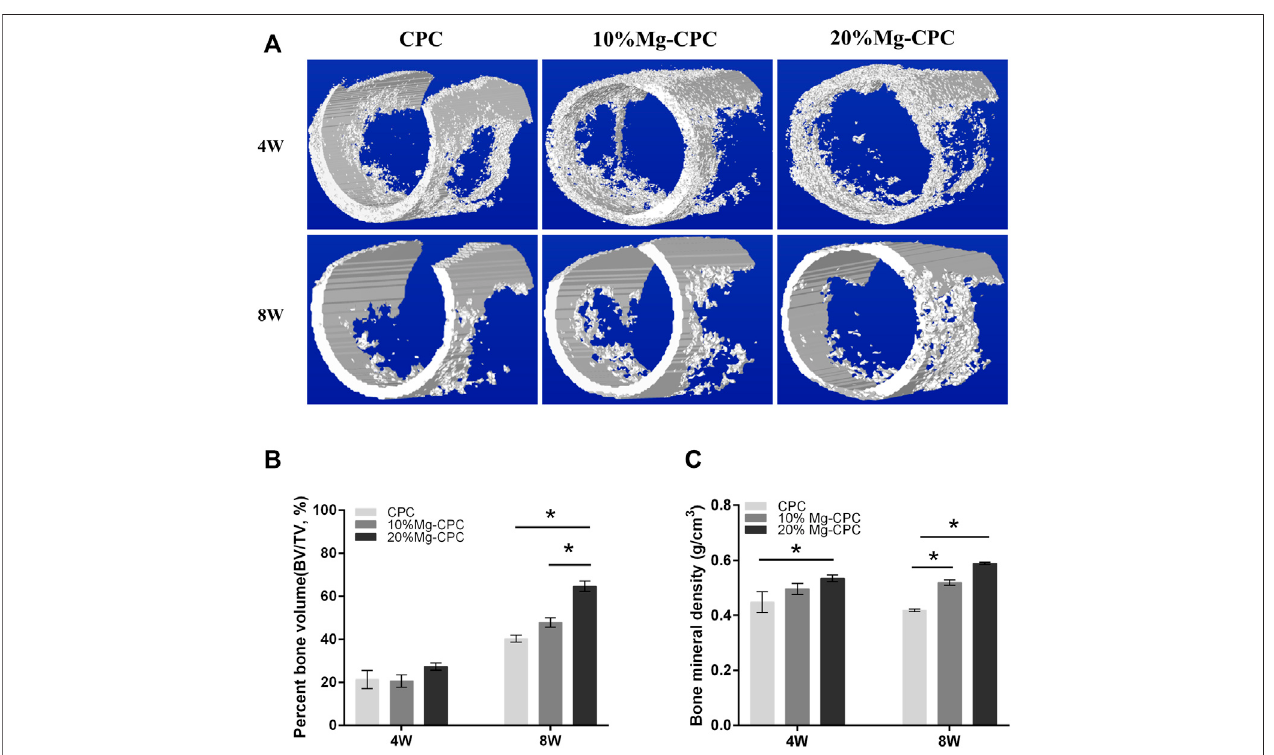
FIGURE6| Micro-CTevaluationaftersurgery. (A) 3Dreconstructionmodelsofnewboneformationatthedefectsitesatdifferenttimepoints; (B) ThePercentbone volume (BV/TV) of newly formed bone tissue at 4 and 8 weeks after surgery; (C) The bone mineral density values of different cement groups at 4 and 8 weeks after surgery (* p <